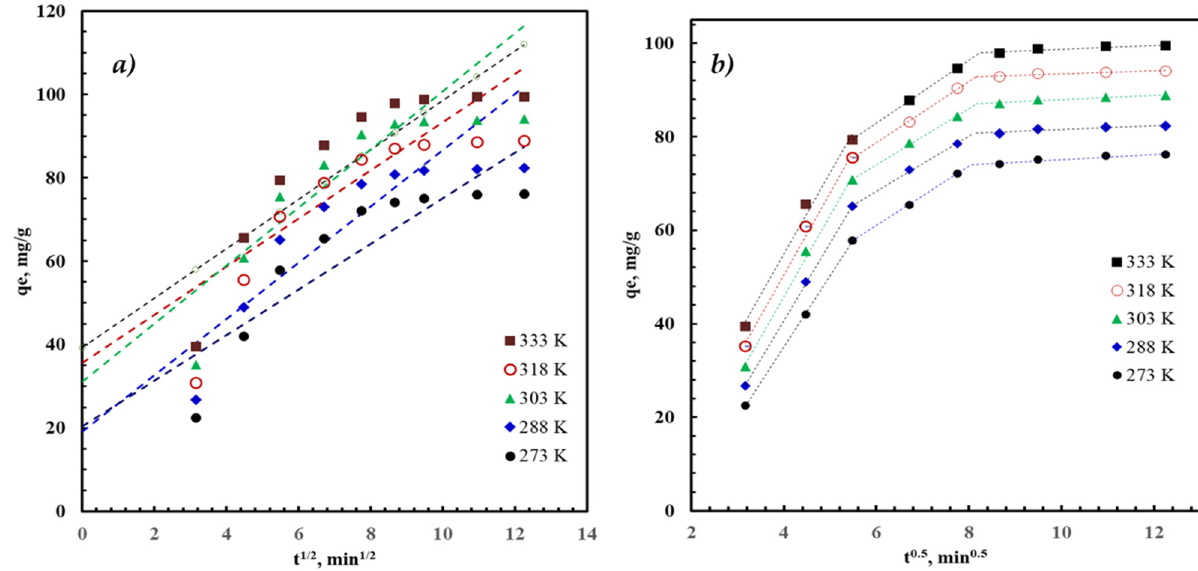
Figure 7. The adsorption capacity (symbols) of AZM using AFAC fitted to the ( a ) one stage IPD kinetic model (curves) and ( b ) three-stages IPD kinetic model (dashed-curves). Conditions: pH = 9, C 0 = 100 mg/L, and dose = 1 g/L. Table 5. IPD parameters for the adsorption of AZM on AFAC.